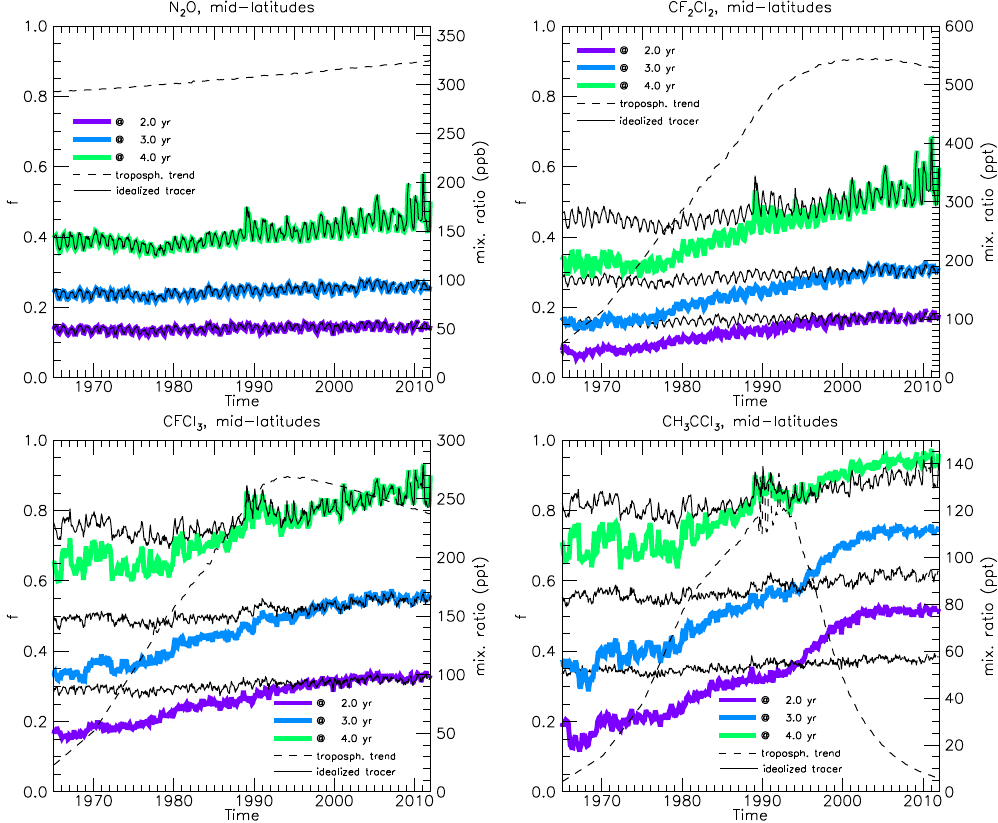
Figure 3. Temporal evolution of FRFs calculated by the current formulation. Results for the realistic tracers are shown in colour. The results for the idealized tracers (cf. Fig. 2) are shown as black lines for comparison. The related tropospheric trend of the species is plotted in dashed lines over the entire range in order to compare the magnitudes. There are obvious deviations between realistic and idealized tracers that depend on the tropospheric trends of the species (see the text for an